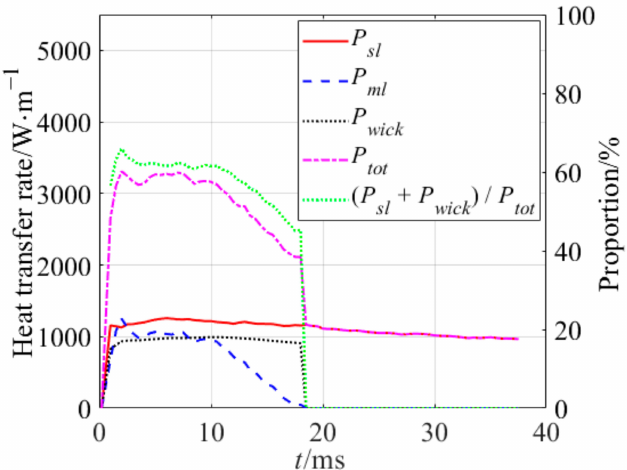
Figure 18. Heat transfer rates from different parts vary with time on 100 bilayer LbL heater at ◦ ∆ T w = 22.69